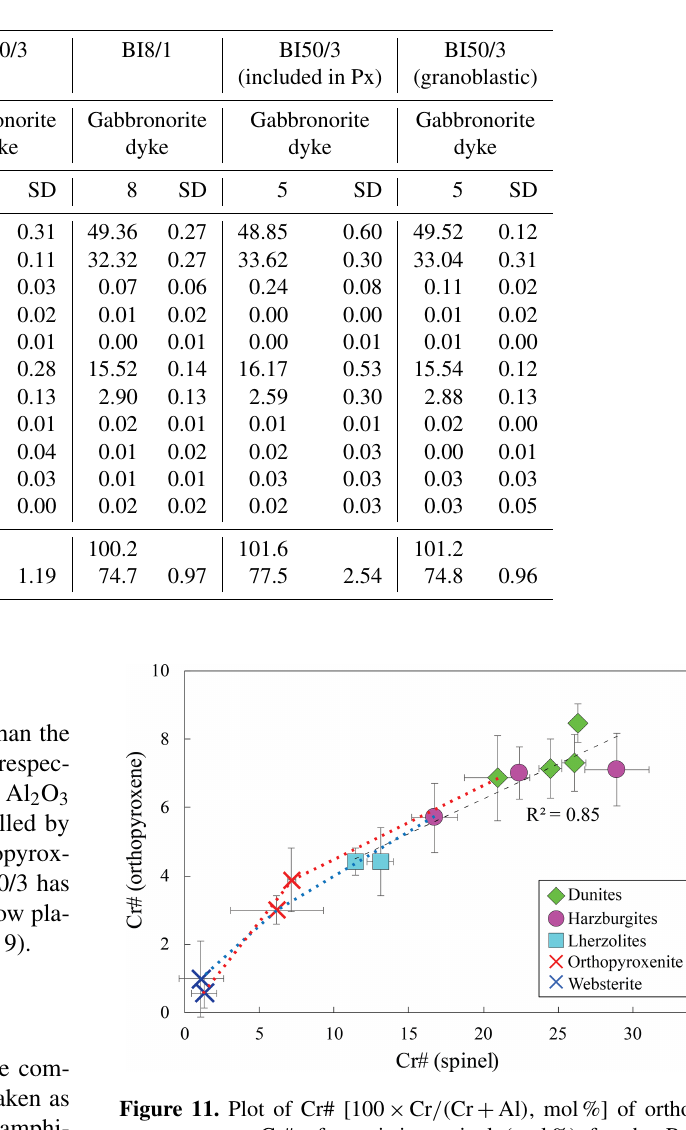
alleled by associated spinel (Fig. 11). Clinopyroxene and am- phibole (pargasite) present in the websterite micro-layer ex- hibit high Mg# of 90 and 85,